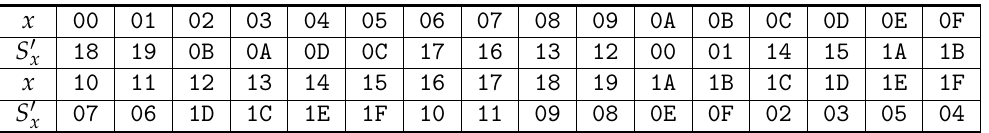
Table 3. 5-bit code abiding representation constructed from PRESENT